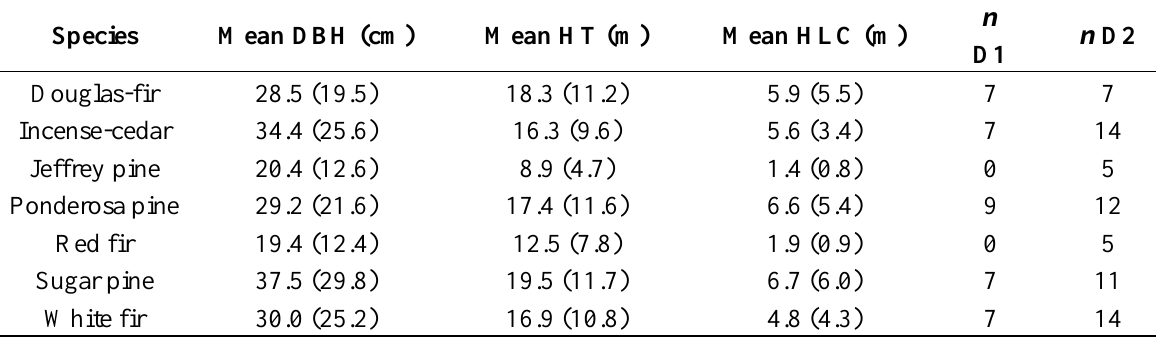
Table 2. Summary tree